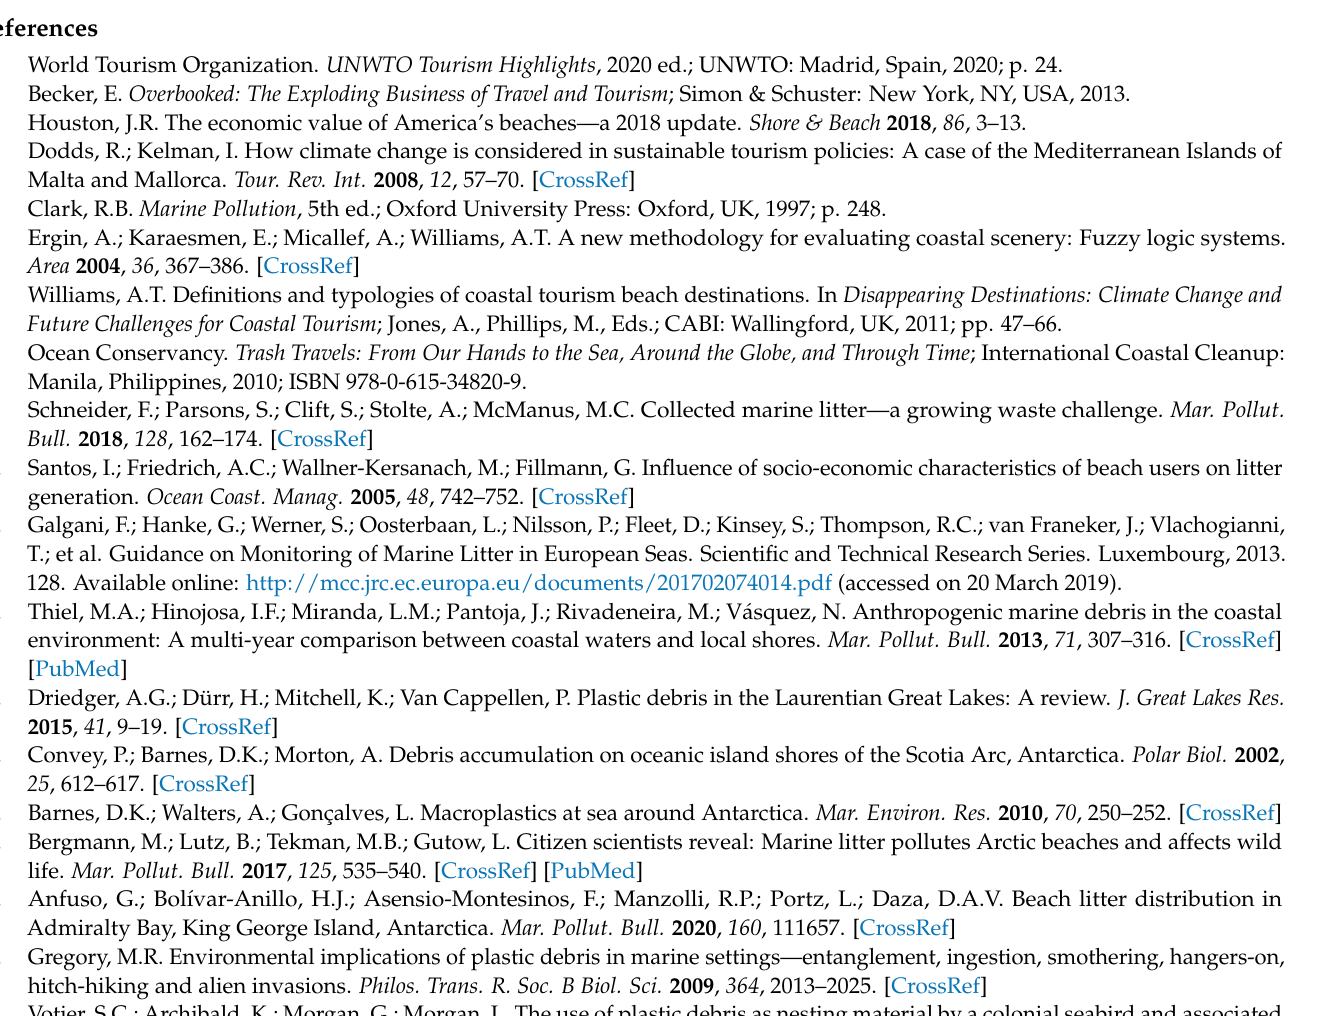
Figure A1. Total beach litter items ( a ) and densities ( b ) observed at the beaches investigated in February, March and April 2019. Total beach litter items per beach typology ( c ) and cleaning operations ( d ). Boxes enclose 50% of data; associated standard deviations are represented with whiskers, averages with red dots, outliers with white dots and median values with black lines.